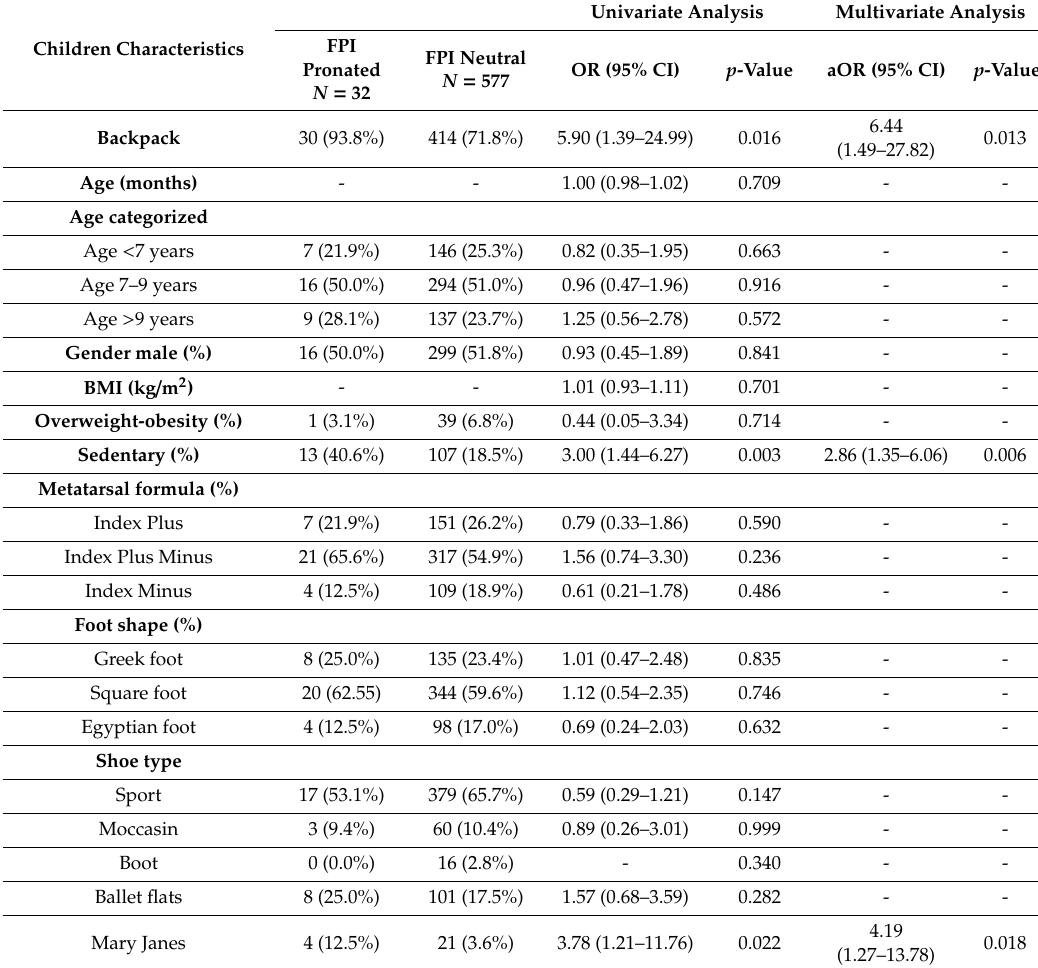
Table 3. Predictors of the changes from neutral foot to pronated